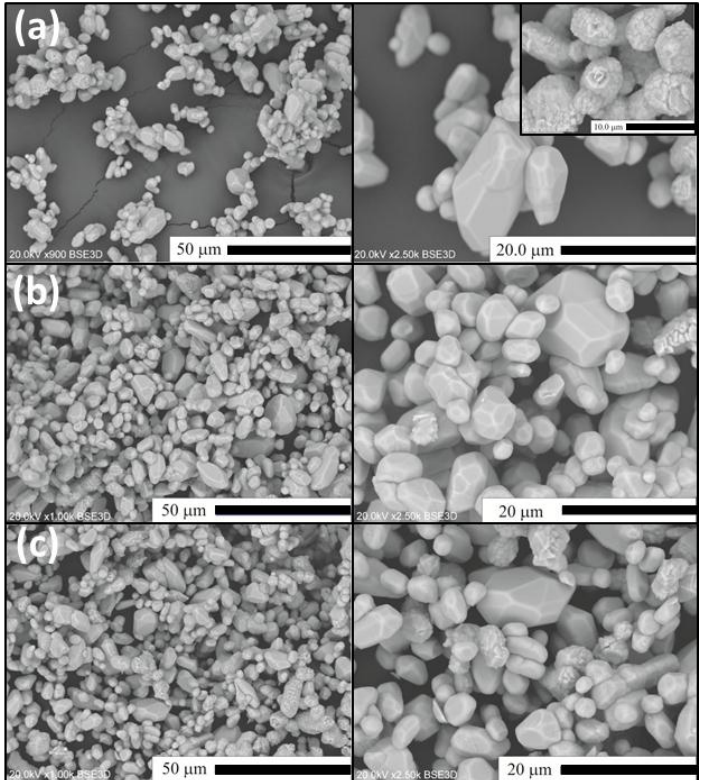
Figure 4. SEM images of Lu 2 O 3 were prepared using Series II synthesis for ( a ) SII-1; ( b ) SII-2; ( c )